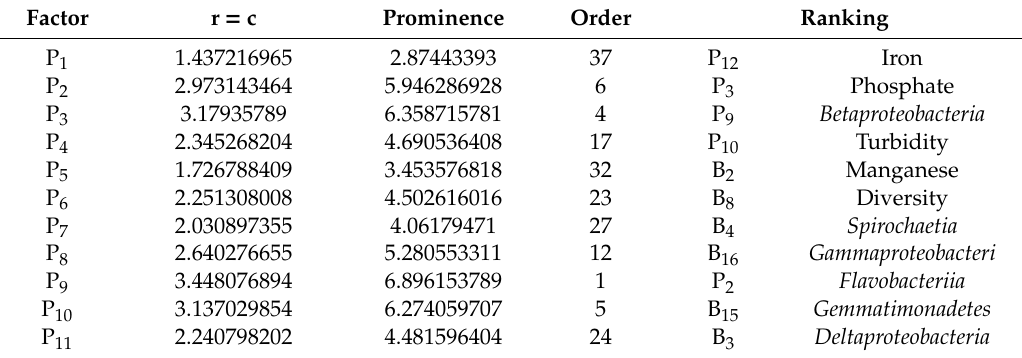
Table A1. Values of prominence for each factor and final ranking of